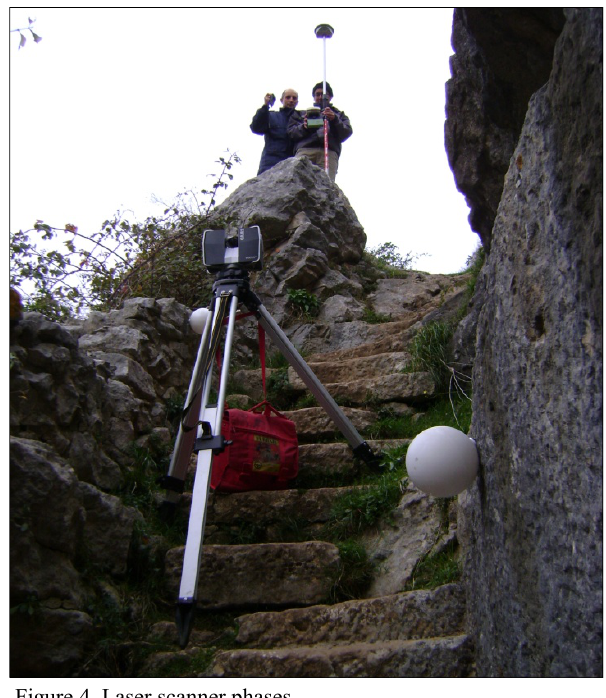
Figure 4. Laser scanner phases